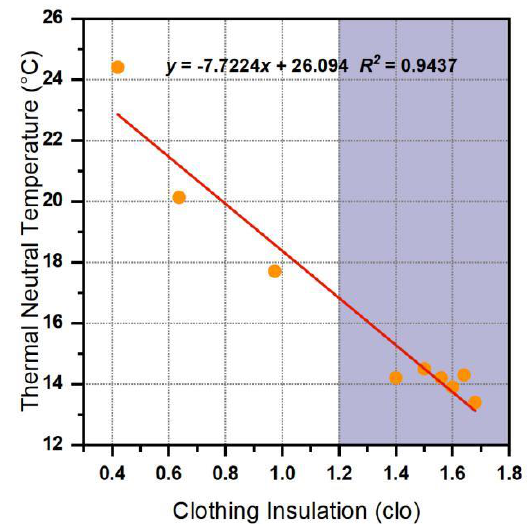
Figure 15. The relationship between the neutral temperature and the clothing insulation.